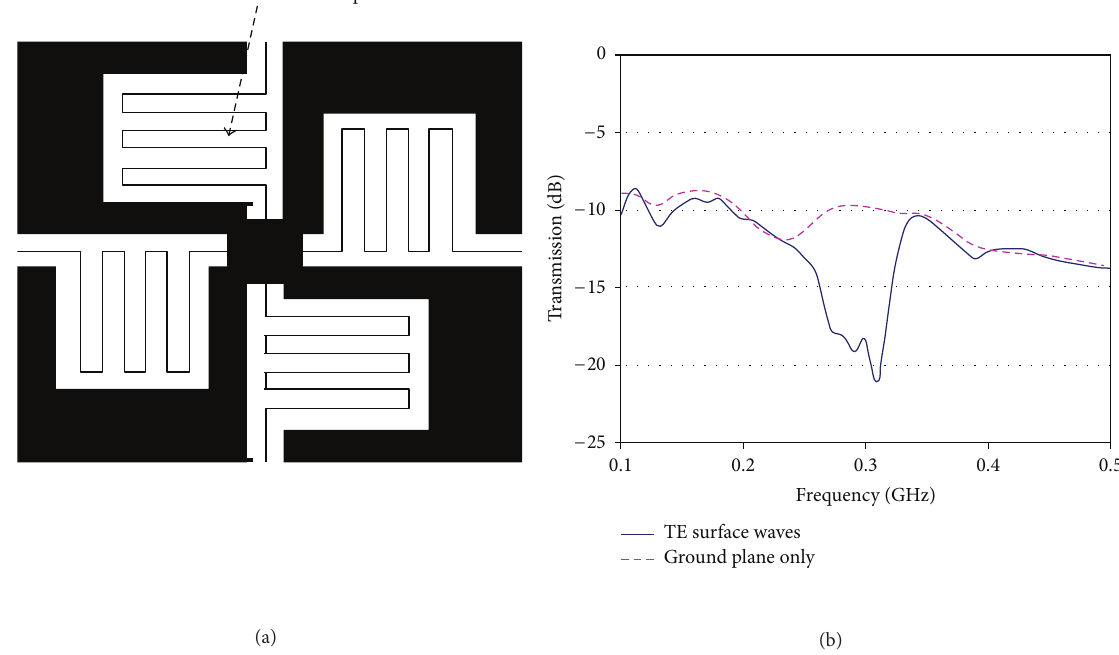
Figure 8: (a) Schematic of the small EBG structure with thin microstrip line developed on 1.6mm FR4 and (b) transmission responses ( 𝑆 21